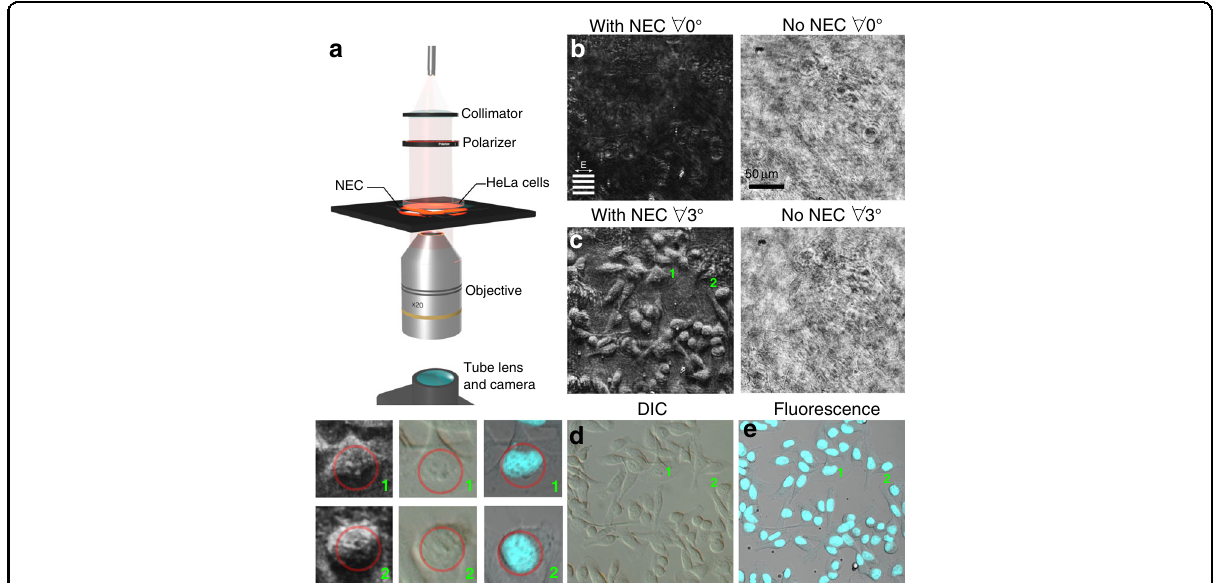
Fig. 4 Phase-imaging HeLa cells. a The experimental arrangement — 637 nm light is collimated and polarised with the electric fi eld parallel to the grating lines before passing through a Petri dish containing fi xed HeLa cells above the NEC. On passing through the NEC the light is collected by a ×20 objective and imaged onto a camera. b , c Images obtained for the same region of cells with and without the NEC at two different tilts with respect to the incident light b no tilt Θ = 0°, c tilt Θ = 3°. The regions labelled 1 and 2 are magni fi ed in the inset. Grating orientation and incident polarisation as indicated by inset in b . d Conventional microscope images of the same cells using DIC (left panel) and fl uorescence (right panel). The blue regions in the fl uorescence image highlight the cell nuclei. Inset: Enlargements of the images obtained by the NEC at Θ = 3° tilt, the DIC and fl uorescence microscopes as indicated by the numbers. The circles highlight nucleoli inside the nucleus of each